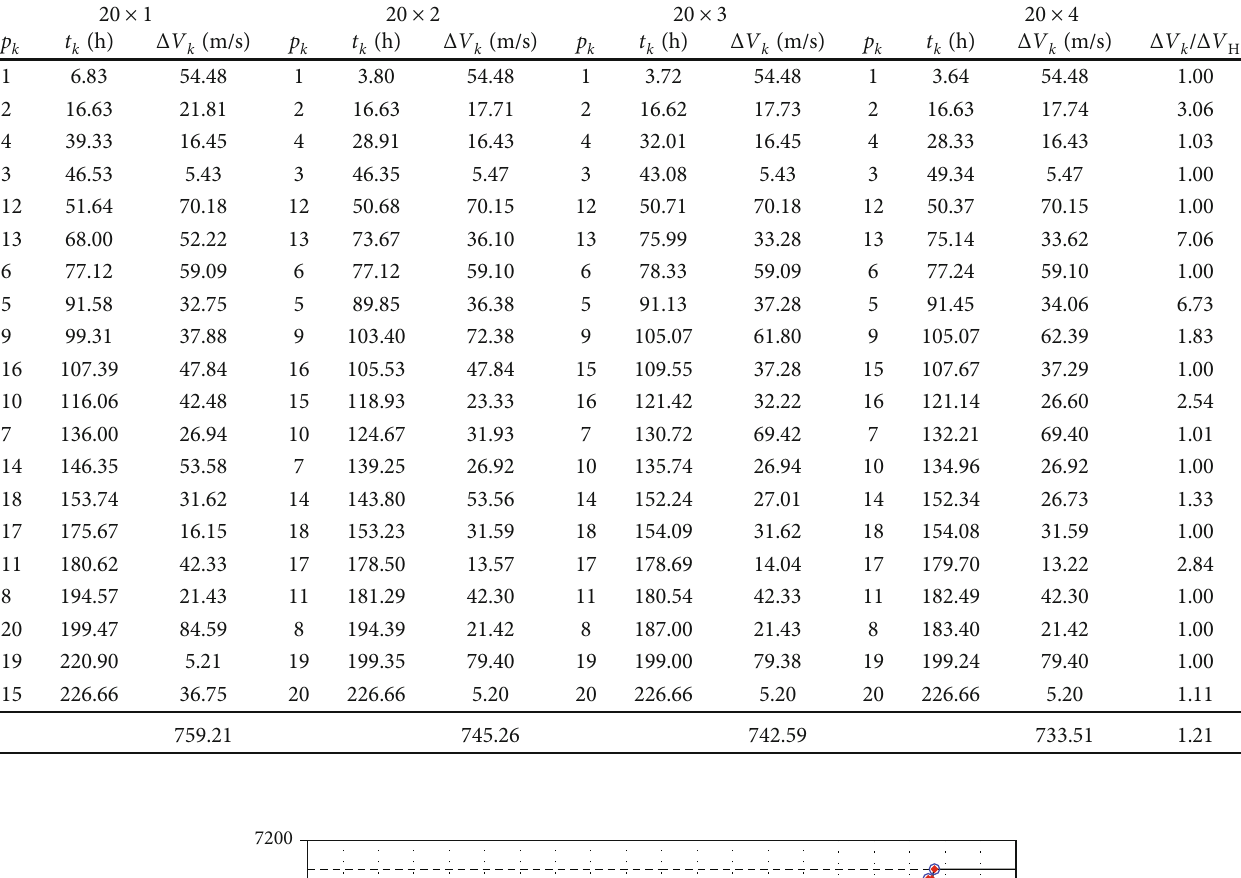
Table 5: Solutions of the 20-target problem after EOS time-free optimization.